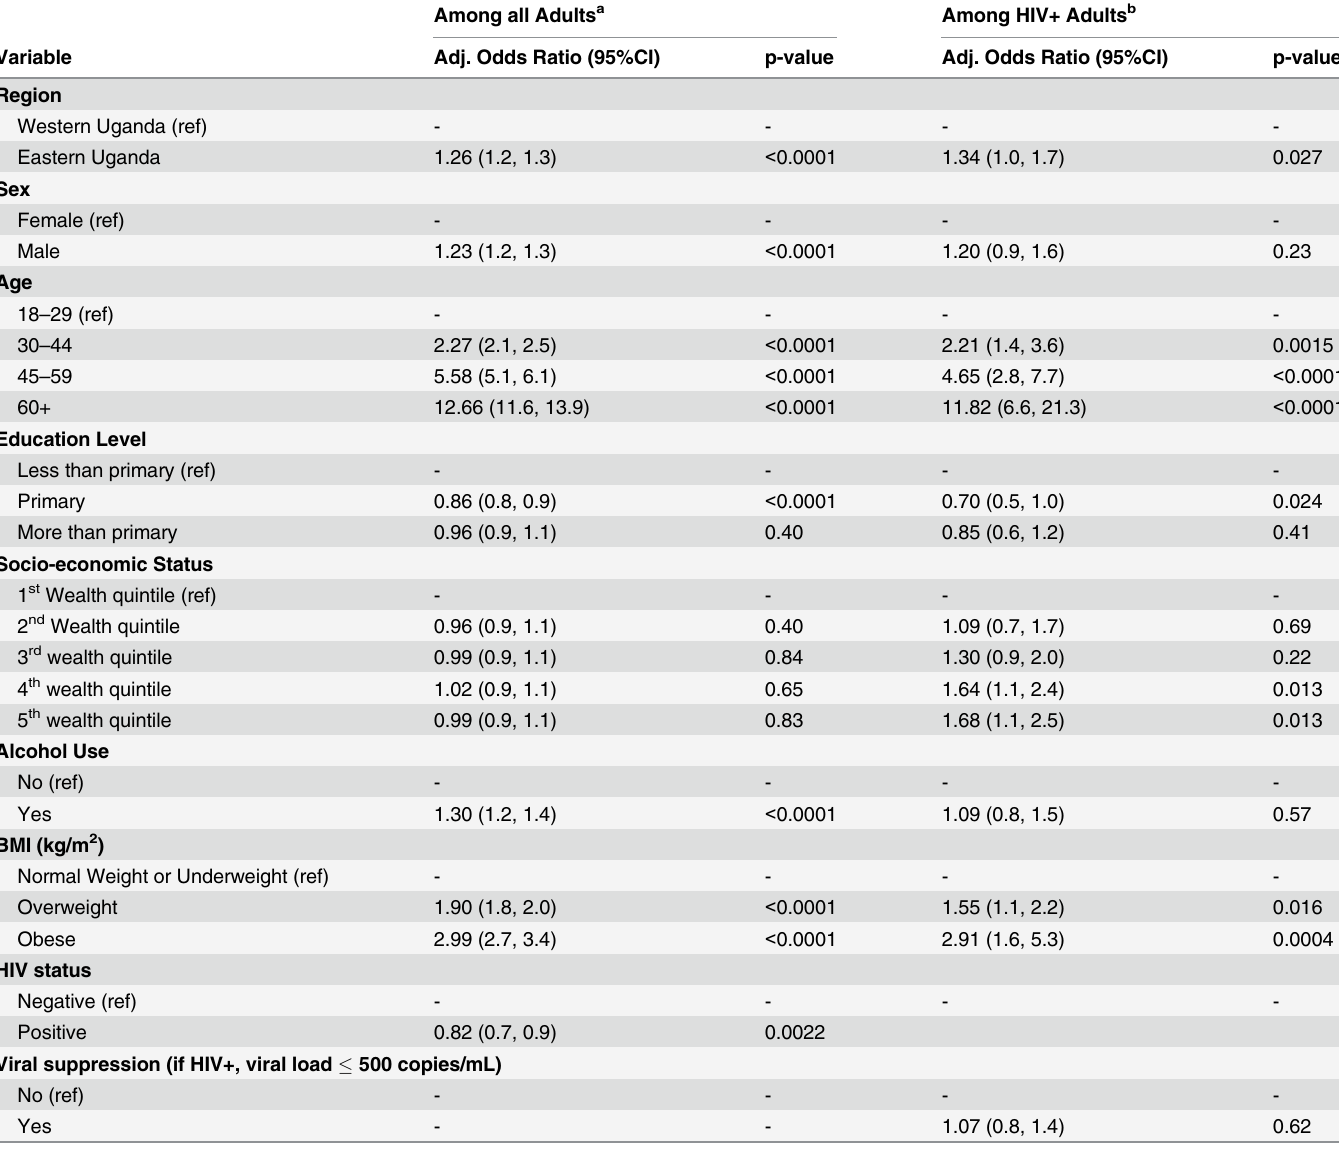
Table 2. Predictors of Hypertension in multivariable